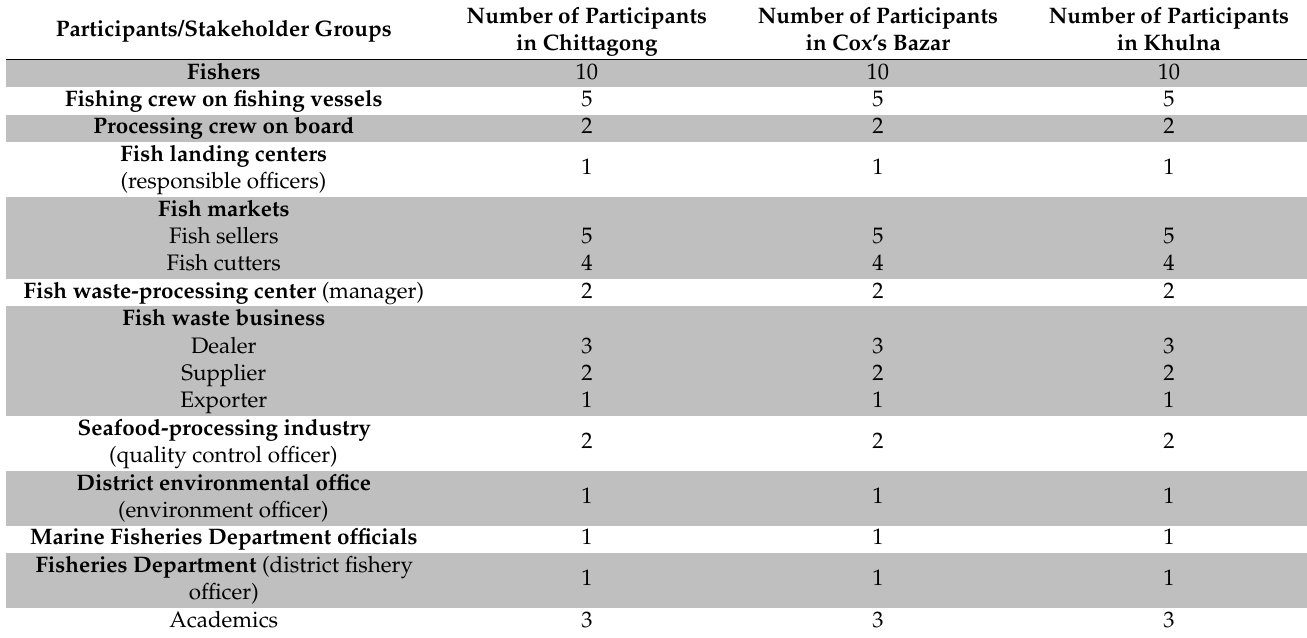
Table 1. Sample of interviewed